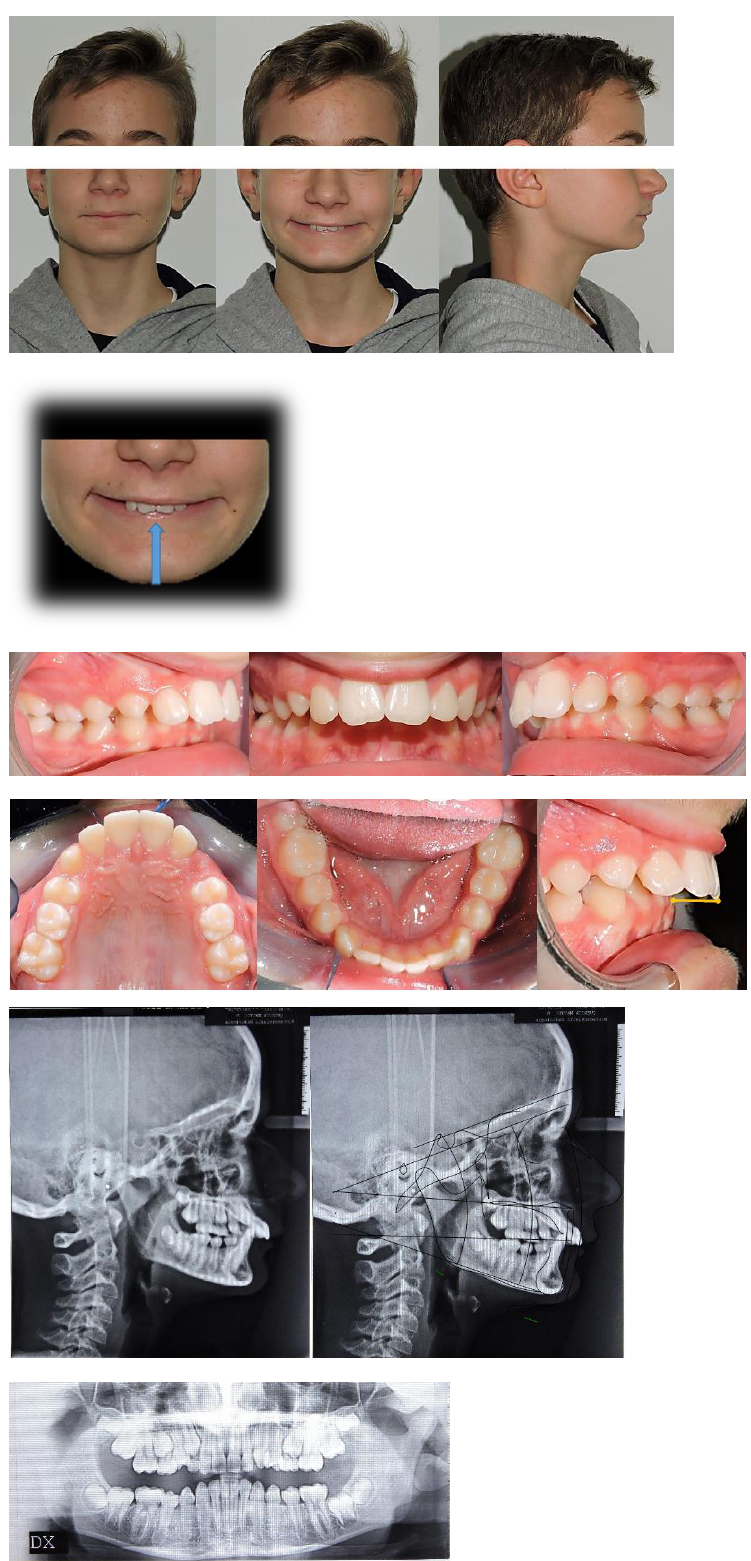
Figure 1. Pre-treatment intraoral, extraoral photographs and radiographic